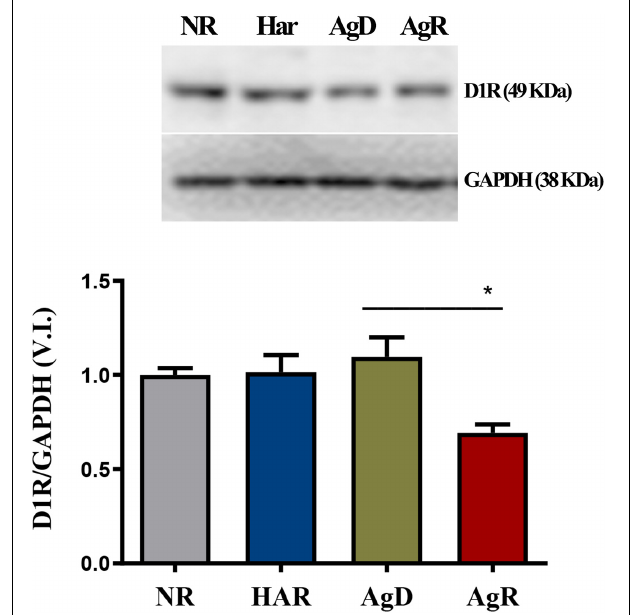
FIGURE 4 | Expression levels of the Dl dopaminergic receptor. Quantitative analysis of DI receptor expression by Western blot analysis according to the categories NR (gray bar), Har (blue bar), AgD (green bar) and AgR (red bar). GAPDH was used as an internal control for the samples. The values are expressed as the variation index (V.I.) of the means * standard deviation (SD) of the analyzed samples from three independent experiments using the Kruskal-Wallis and Dunn7s test (NR; n = 9, Har; n = 10, AgD; n = 15; AgR; n = 10 animals). * corresponds to the statistical significance ( p < 0.05) between AgR and